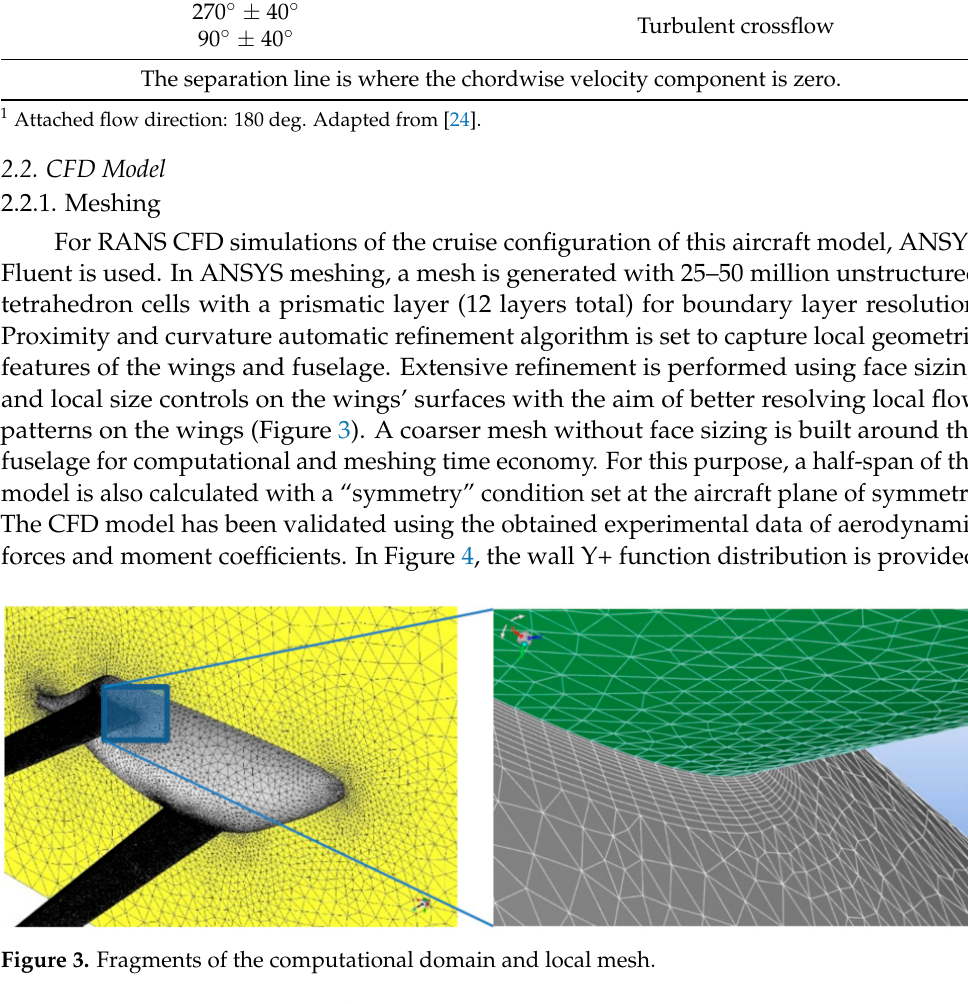
Figure 4. Distribution of wall Y+ values on the wings and fuselage surface. 2.2.2. Governing Equations and CFD Setup For the studied case of a steady flow external aerodynamics, conservation equations are solved, including the continuity equation for mass, which can be expressed in a gen- eral form as follows: